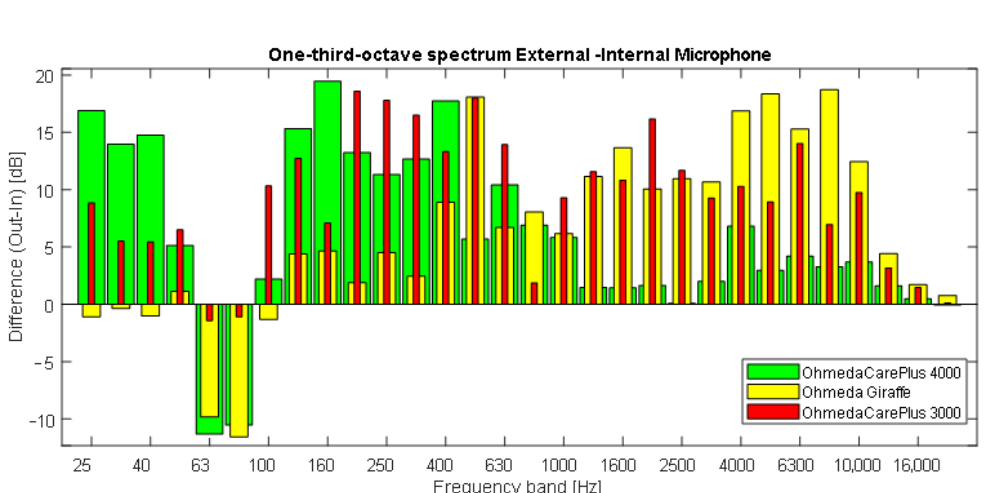
Table 4. The overall noise level inside and outside of the incubators (Incubators on; external sound source on).